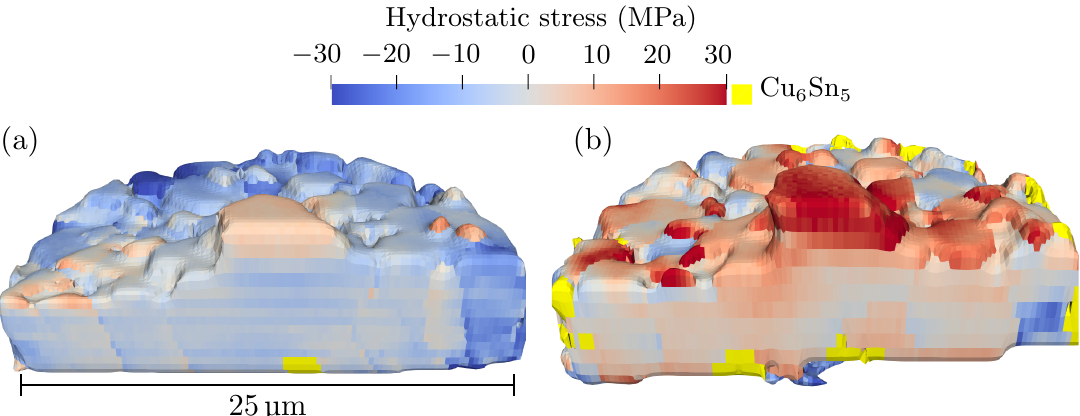
Figure 12. 3D reconstruction of hydrostatic stress field in the tin coating; the volume is sliced to reveal the internal structure. The stresses are calculated using the mean lattice parameters of the whisker as a stress-free reference. Yellow colour indicates Cu treatment of 150 ◦ C for three